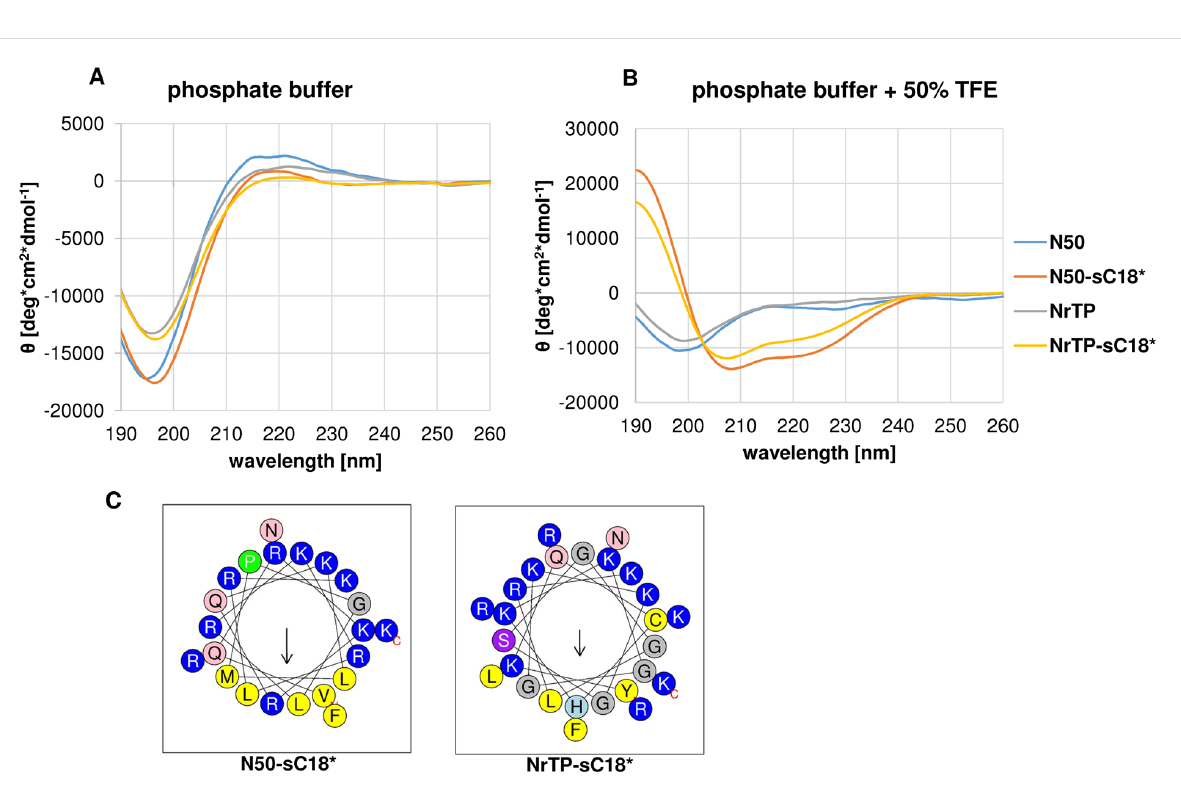
Figure 1: Circular dichroism spectra of the novel peptides solved in 10 mM phosphate buffer (pH 7) (A), or phosphate buffer with the addition of TFE (50%) (B). Peptide concentration was 20 µM. (C) Helical wheel projections of the peptides N50-sC18* and NrTP-sC18*, respectively [26].